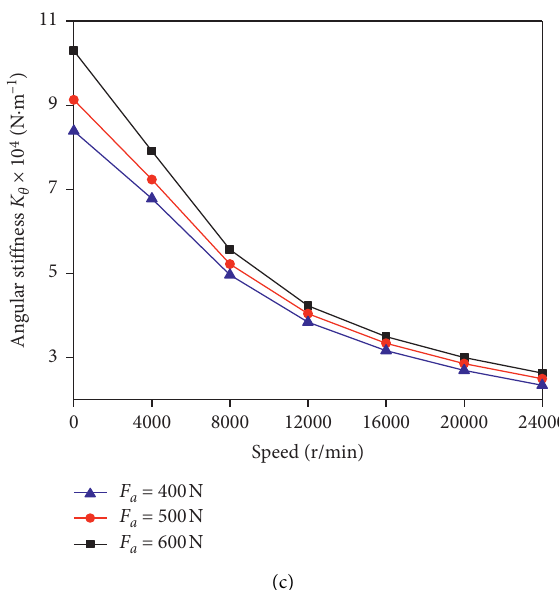
Figure 21: Influences of the speed and preload on the composite stiffness. (a) Radial stiffness. (b) Axial stiffness. (c) Angular